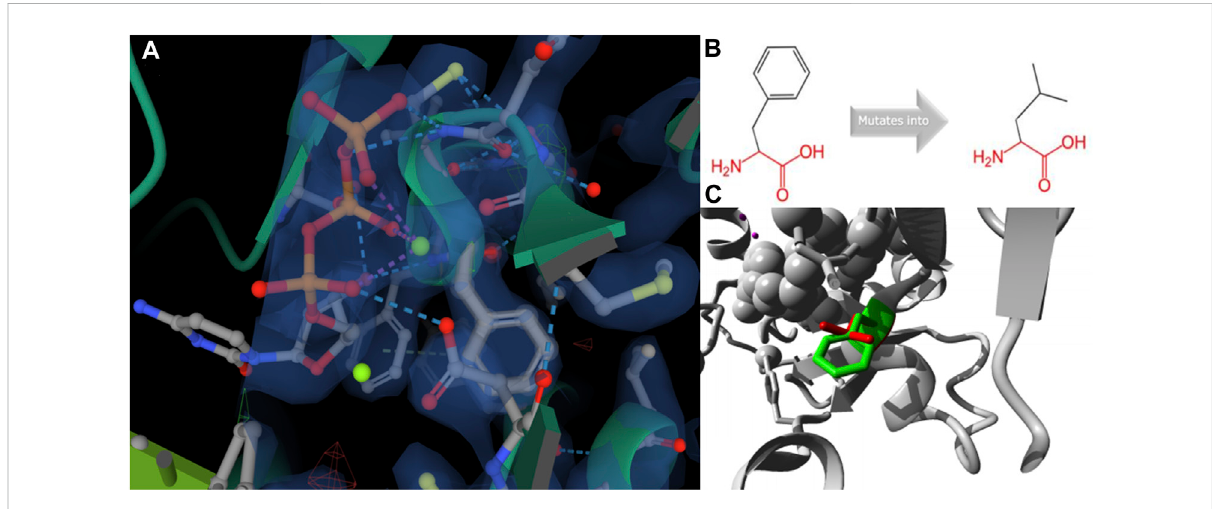
FIGURE 4 3D structure (A, C) and chemical structure changes (B) of position 427 on REV1